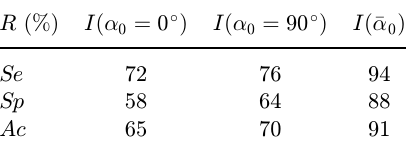
Table 2. Operational characteristics of the technique of polarization-variable laser auto°uorescence of histological sections of biopsy of cervix uteri endometrium of Group 1 (dysplasia) and Group 2 (cervical microinvasive